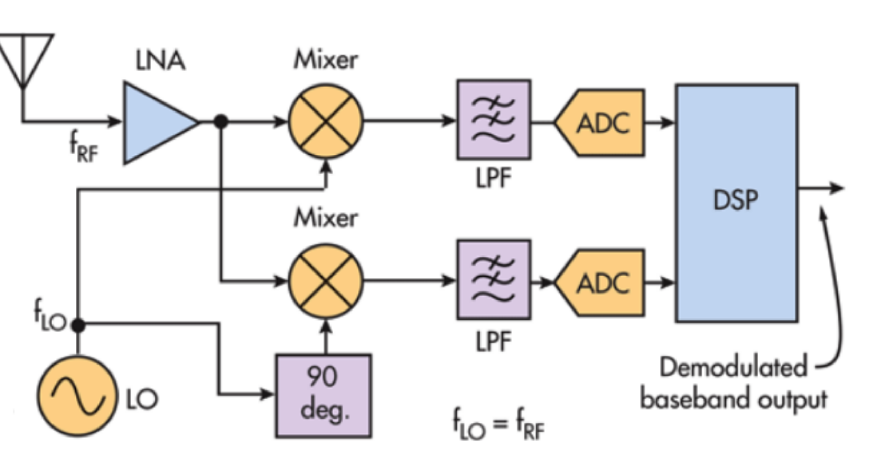
Figure 7. Representative block diagram of the internal architecture of the receiver in the “Adalm- PLUTO” device.